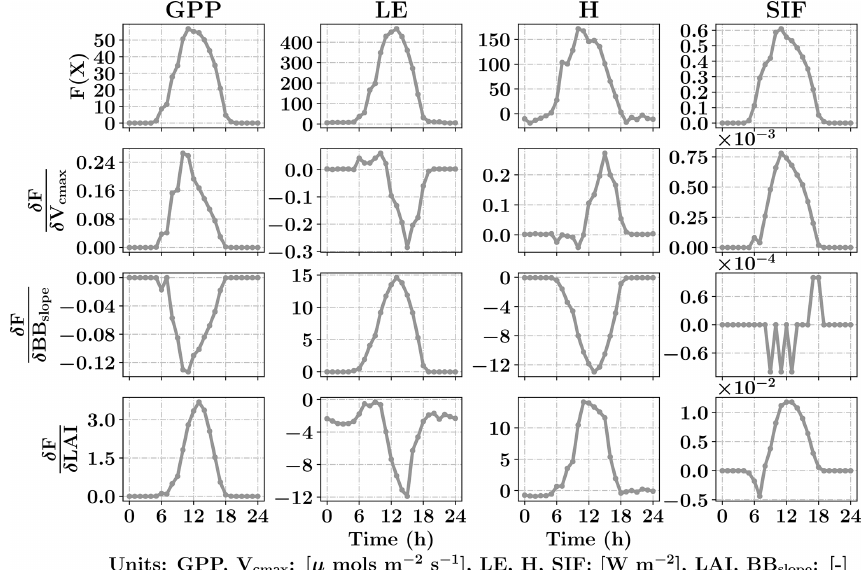
Figure 3. Diurnal variability of GPP, LE, H and SIF from SCOPE model simulations (top row) for a typical day in the growing season (3 August 2010) for C 4 corn using data from the Nebraska Mead-1 flux tower site with parameter values V cmax = 50µmolsm − 2 s − 1 , BB slope = 7 and LAI = 4. Second, third and fourth rows from the top shows the diurnal variability in the gradient of GPP, LE, H and SIF with respect to the parameters using SCOPE with positive perturbations δV cmax = 5µmolsm − 2 s − 1 , δ BB slope = 1 and δ LAI = 0 . 5 which constitutes the Jacobian matrix for the inversions. It can be observed that the Jacobian matrix is nonlinear with maximum values near the midday period. Our retrieval framework uses concatenated 3-day GPP and LE fluxes (modeled and observed) and their gradients successively within a 3-day